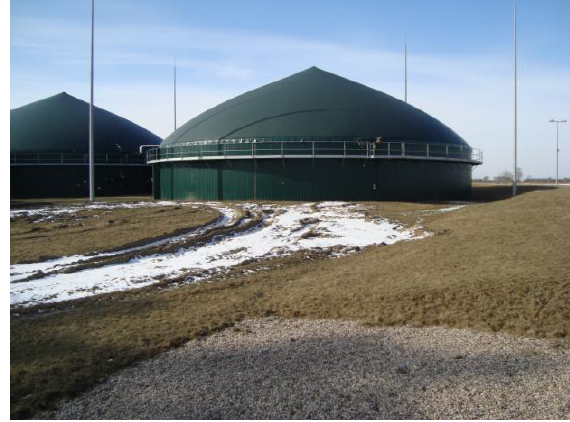
Fig. 1. View of fermentation chambers in the Ryboły biogas plant.